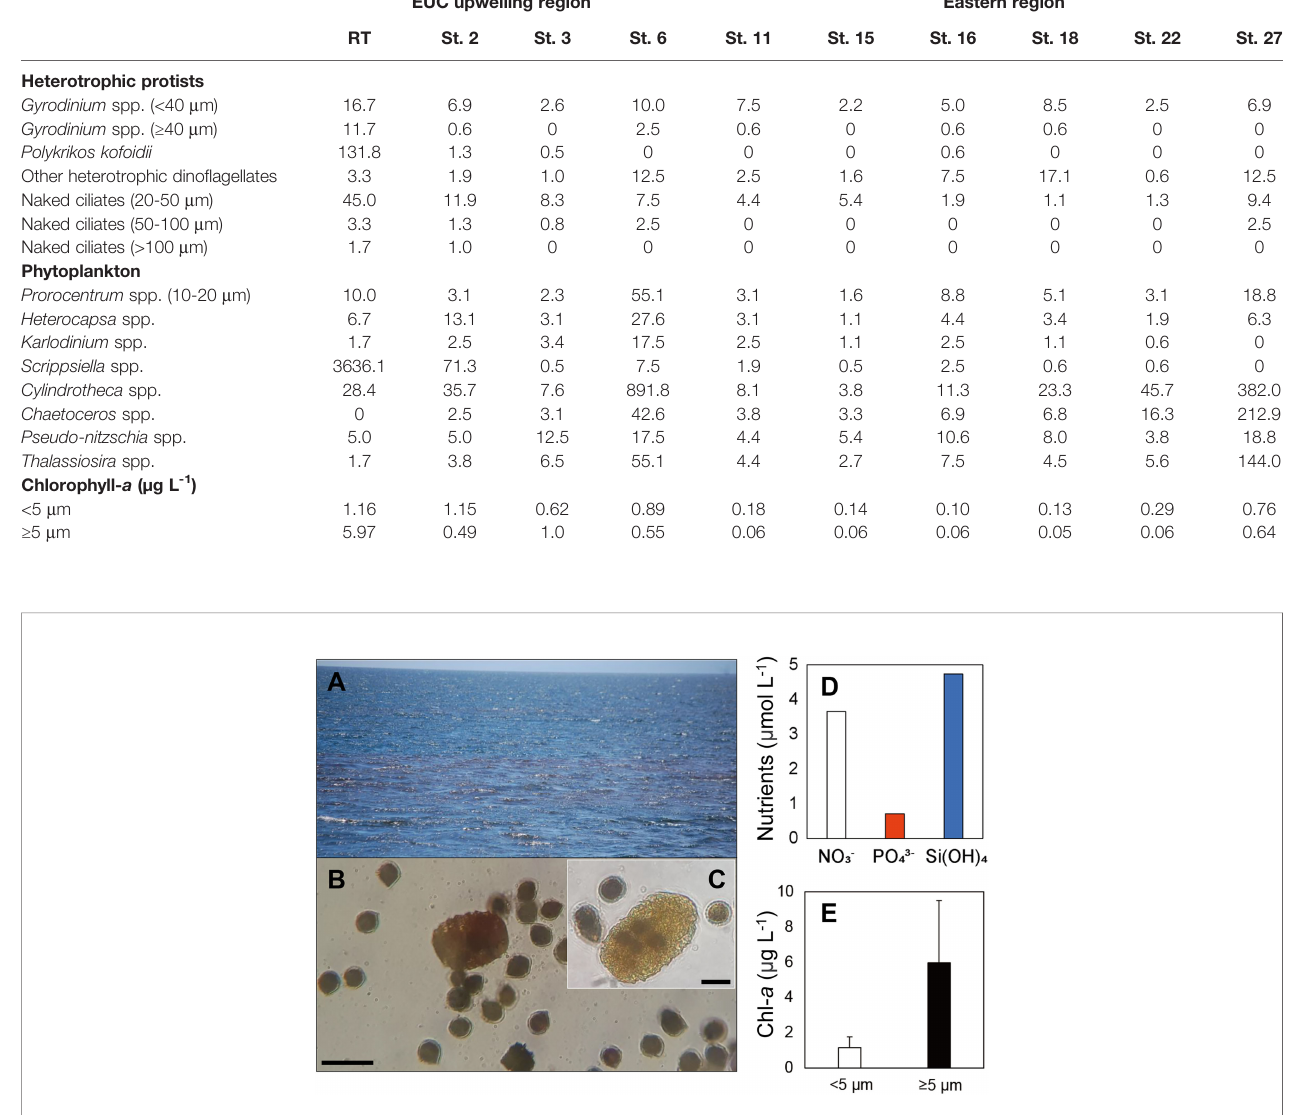
FIGURE 7 | A red tide (RT) event observed in October 2018 in Elizabeth Bay on the west side of Isabela Island of the Gala ́ pagos Archipelago. (A) A general view of the red tide event from the surface. (B) The two dominant taxa: dino fl agellates Polykrikos kofoidii and Scrippsiella lachrymosa , observed in a preserved sample collected from the RT site. (C) P. kofoidii cell assumed to have fed on several S. lachrymosa cells. (D) Nutrient concentrations ( m mol L -1 ) for nitrate NO − 3 , phosphate PO 3 − 4 , and silicic acid (Si[OH] 4 ) measured at the site. (E) Size-fractionated chlorophyll- a concentrations (Chl- a , m g L -1 ). Scale bars = 50 m m for B and 20 m m for (C) Error bars in E represent standard deviation of the mean (n=3).